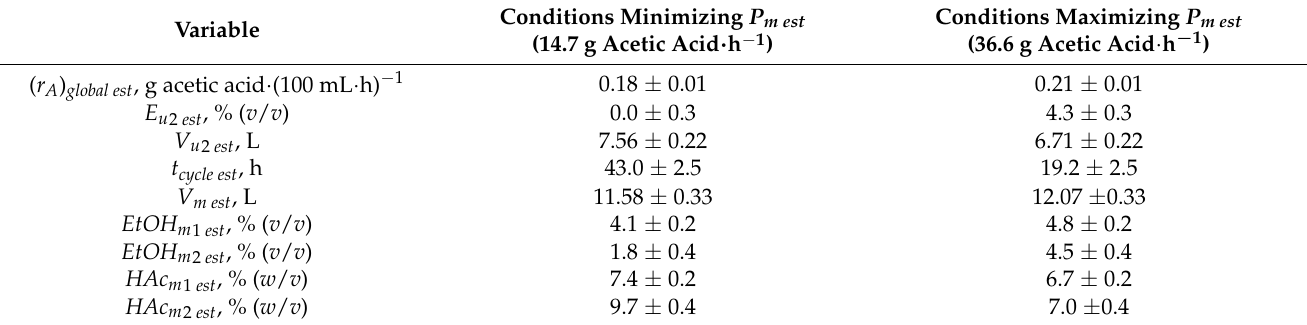
Table 12. Values of the state variables under the operating conditions maximizing and minimizing P m est .